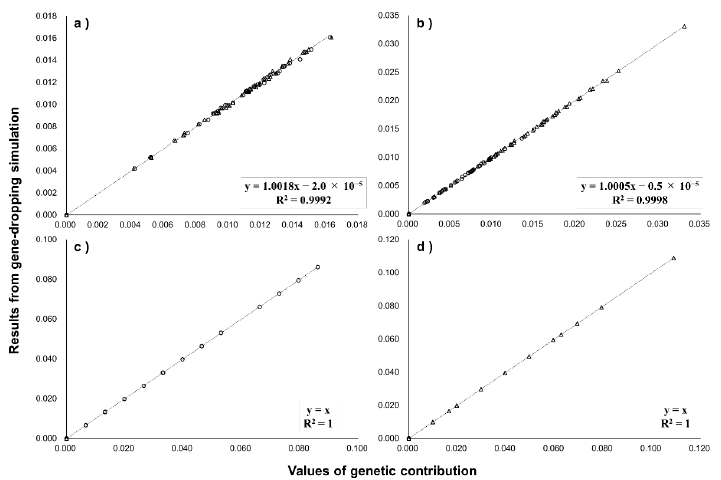
Figure 3. Comparison of average genetic contribution of 100 G1 mice to G8 (horizontal axis) and results of gene-dropping simulation (vertical axis) for genes on autosomes ( a ), X chromosome ( b ), Y chromosome ( c ), and mitochondrial DNA ( d ). Circle: 50 G1 male mice; triangle: 50 G1 female mice.